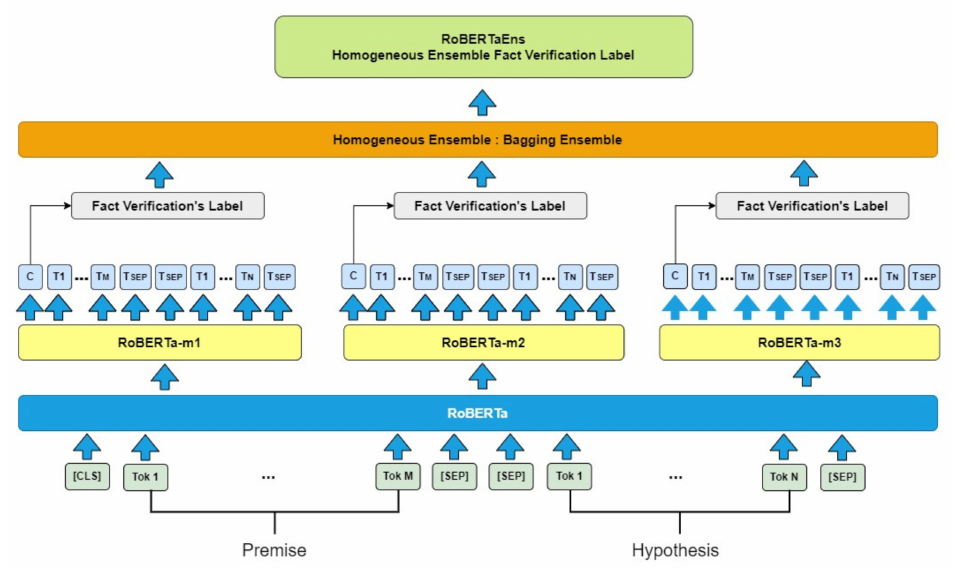
Figure 2. Block diagram of RoBERTaEns